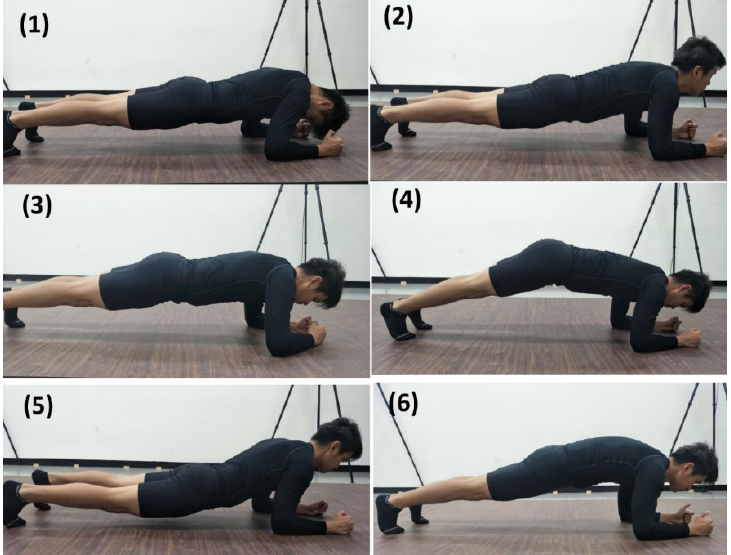
Figure 2. Six plank technique deviations. ( 1 ) HTFN: the head is tilted forward at the neck; ( 2 ) HTBN: the head is tilted back at the neck; ( 3 ) HC: the hands are too close; ( 4 ) HTB: the pelvis is tilted back; ( 5 ) HD: the hip is dropped; ( 6 ) BC: the back is convex.